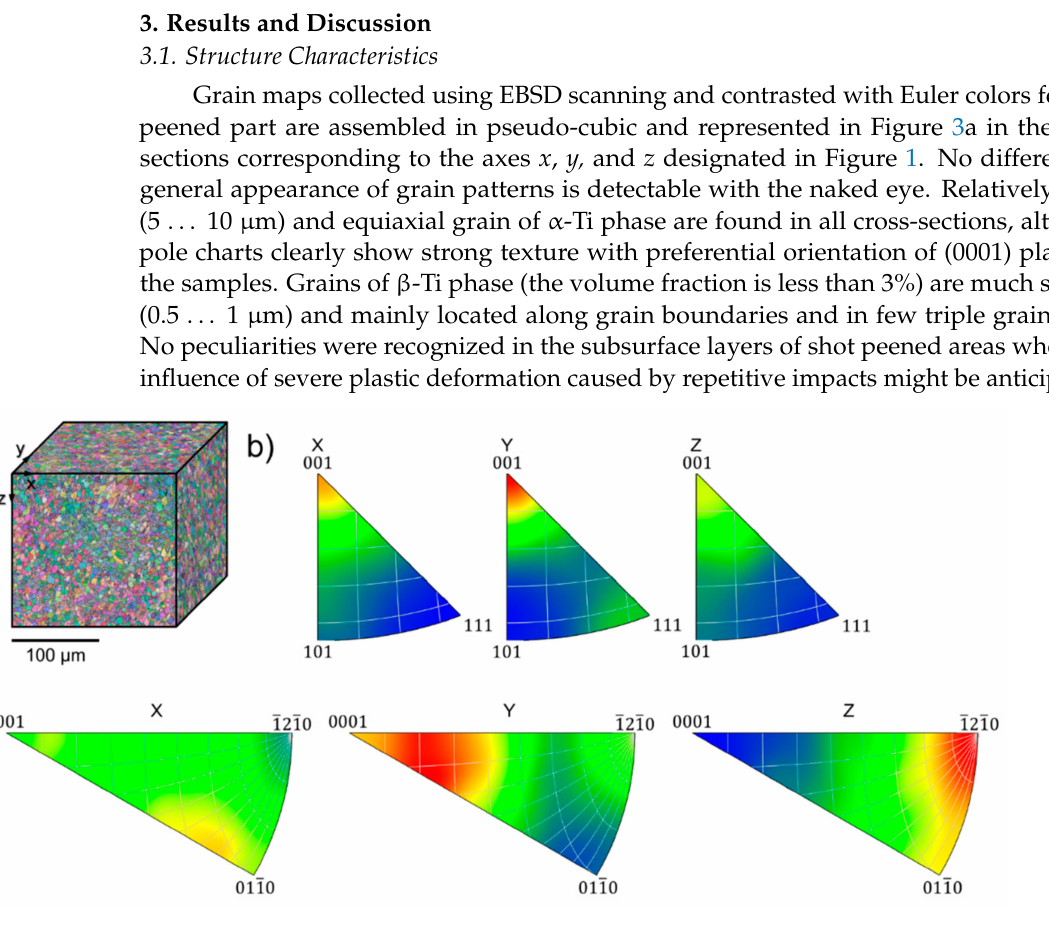
Figure 3. Structure characteristics of a shot peened VT6 samples: ( a ) pseudo-cubic of Euler color maps and IPF color maps for ( b ) β -Ti and ( c ) α -Ti,